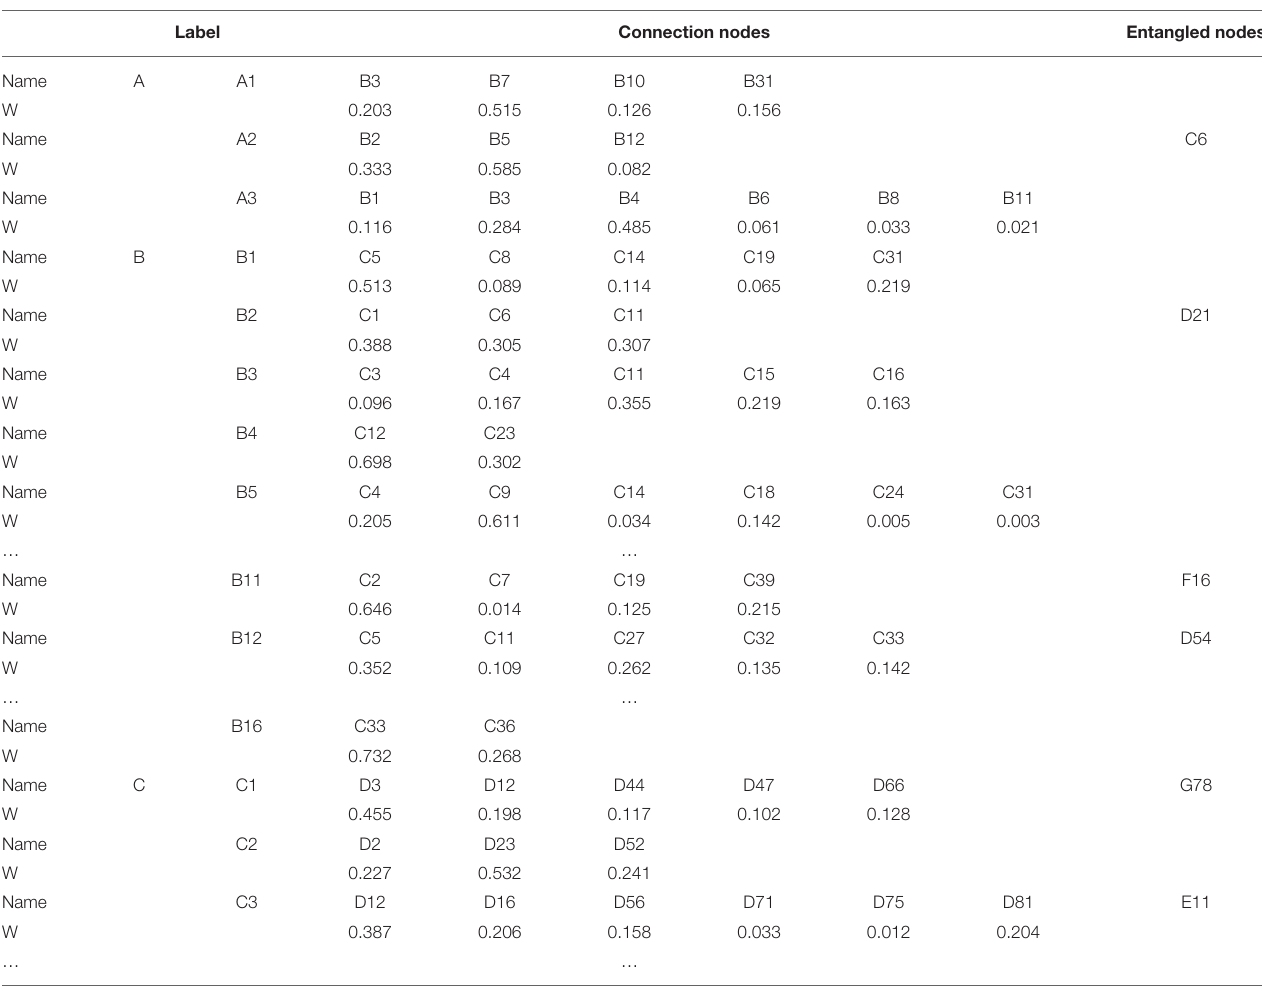
TABLE 5 | Change table of the knowledge graph and weights. Label Connection nodes Entangled